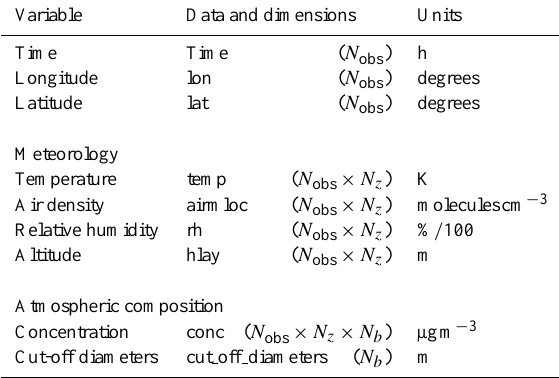
Table 1. List of variables required as input to the OPTSIM software and their corresponding name to be read in a netCDF input file for the default version of the code. N z corresponds to the number of vertical layers in the profiles, N b to the number of size bins and N obs to the number of observations to be